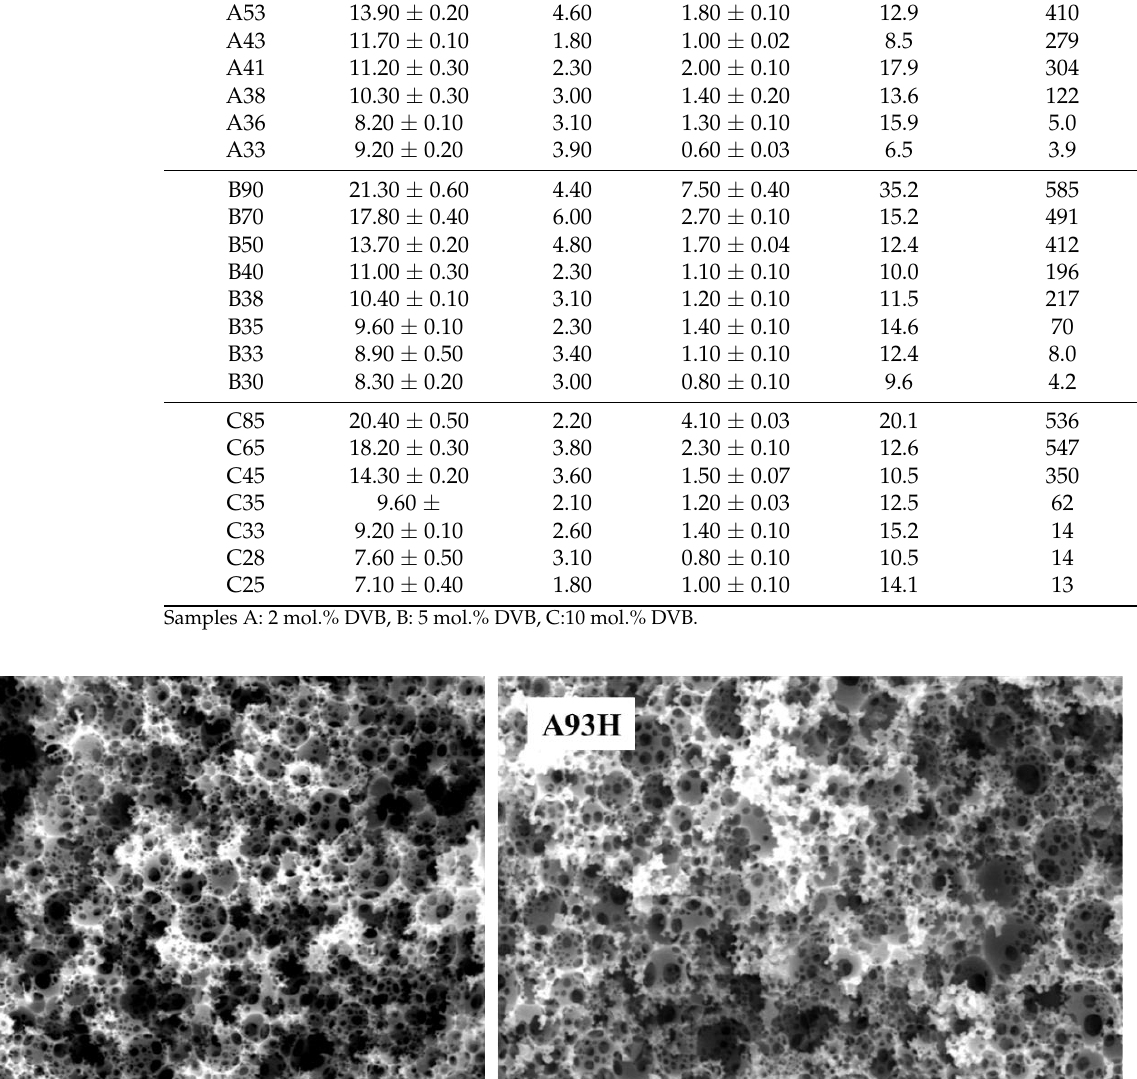
Table 2. Hypercrosslinking effects .